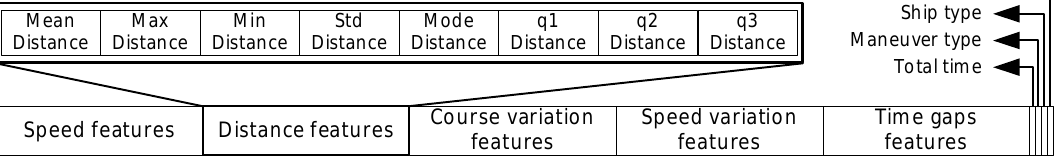
Figure 3. Array of kinematic features for classification.